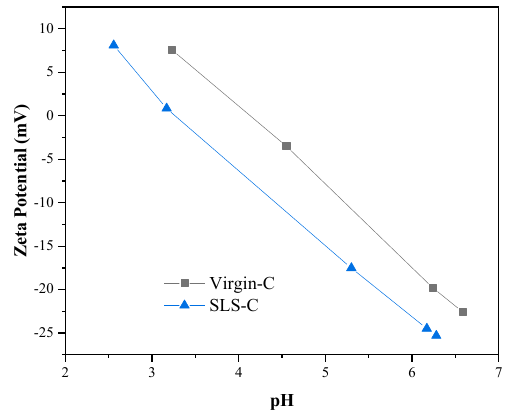
Figure 6. The zeta potential of Virgin-C and SLS-C.